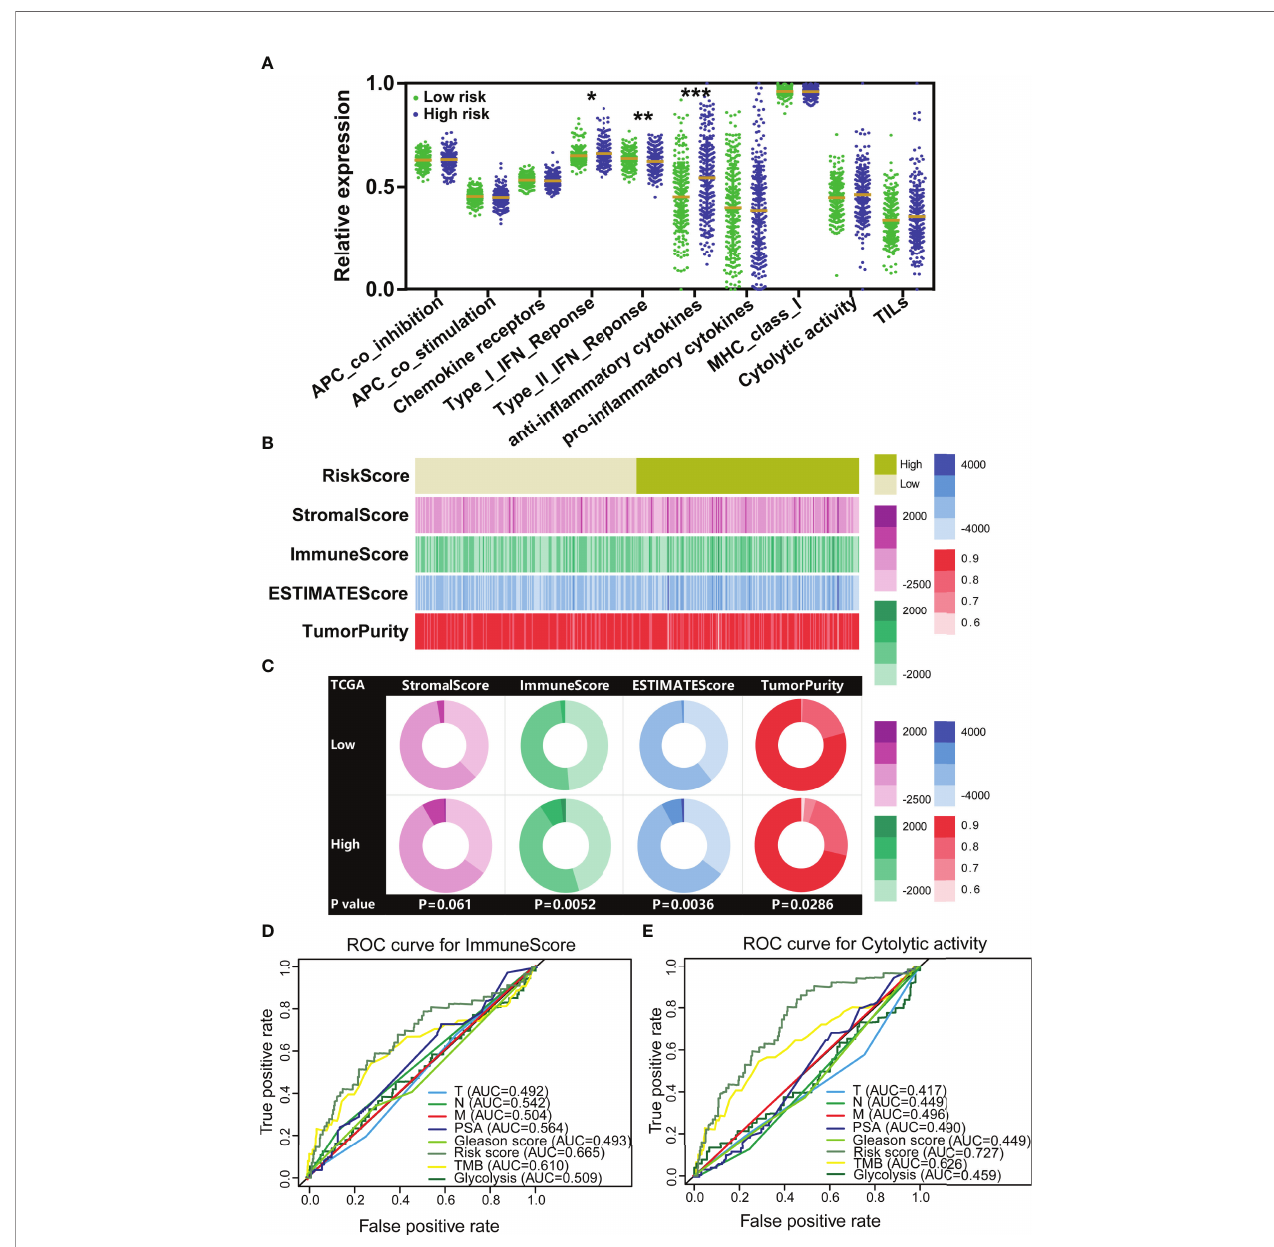
FIGURE 5 | The TILTregSig shows stronger predictive ability for tumor immunity in prostate cancer. (A) The expression levels of immune-related signatures in low- and high-risk groups strati fi ed by the TILTregSig in prostate cancer from the TCGA dataset. (B) The strip chart of risk score, immune score, stromal score, ESTIMATE score, and tumor purity of prostate cancer patients in the TCGA dataset. (C) Pie charts showing the chi-square test of risk score, immune score, stromal score, ESTIMATE score, and tumor purity for low- and high-risk groups in prostate cancer samples from the TCGA dataset. Comparison of the predictive ability of the TILTregSig, TMB, glycolytic activity, PSA levels, Gleason score, Clinical T, Clinical N, and Clinical M for immune score (D) and immune cytolytic activity (CYT) (E) using ROC curve analysis. *, P<0.05. **, P<0.01. ***,